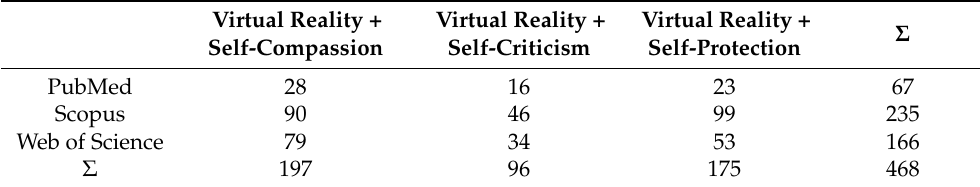
Table 1. Breakdown of search records according to topic and databases applied. Virtual Reality + Virtual Reality + Self-Compassion